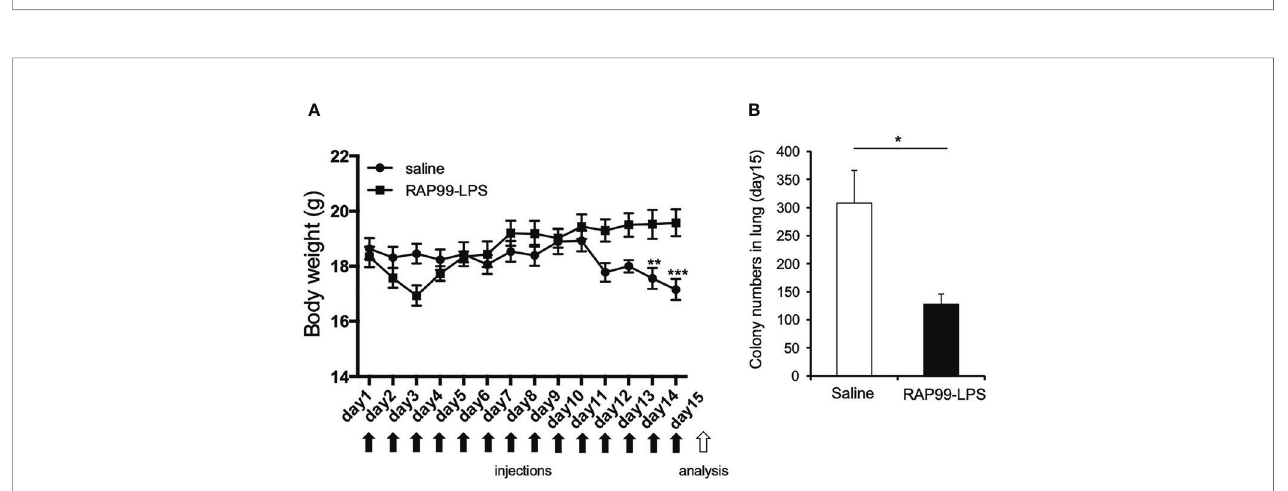
FIGURE 6 | RAP99-LPS treatment suppressed body weight loss and lung metastasis of B16F1 cells. 1 × 10 6 B16F1 cells were intravenously injected into C57BL/6 mice with or without RAP99-LPS (200 m g/day) injections for 14 days. (A) Body weight. (B) The mice were sacri fi ced, and B16F1 cell colonies in the lungs were measured. Mean scores ± SD are shown. *p < 0.05, **p < 0.01, ***p < 0.001; Student ’ s t tests. Black arrows: injections. White arrow: analysis. (n = 4 each; Representative data are